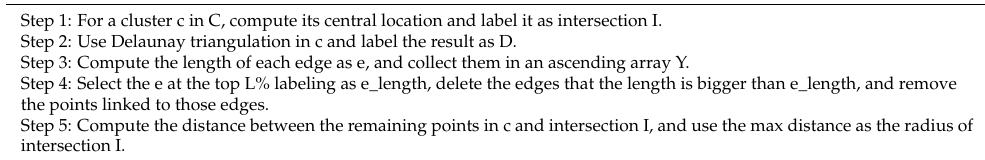
Algorithm 2: Radius computing algorithm by integrating Delaunay triangulation with circle shape structure